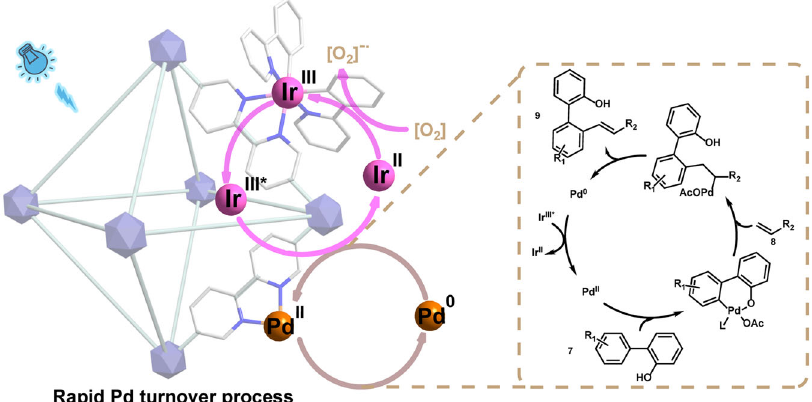
Fig. 7 Proposed mechanism for MOFs based Pd/photoredox catalysis. Taking the Pd-catalyzed C − H alkenylation of 2-phenylphenol as an